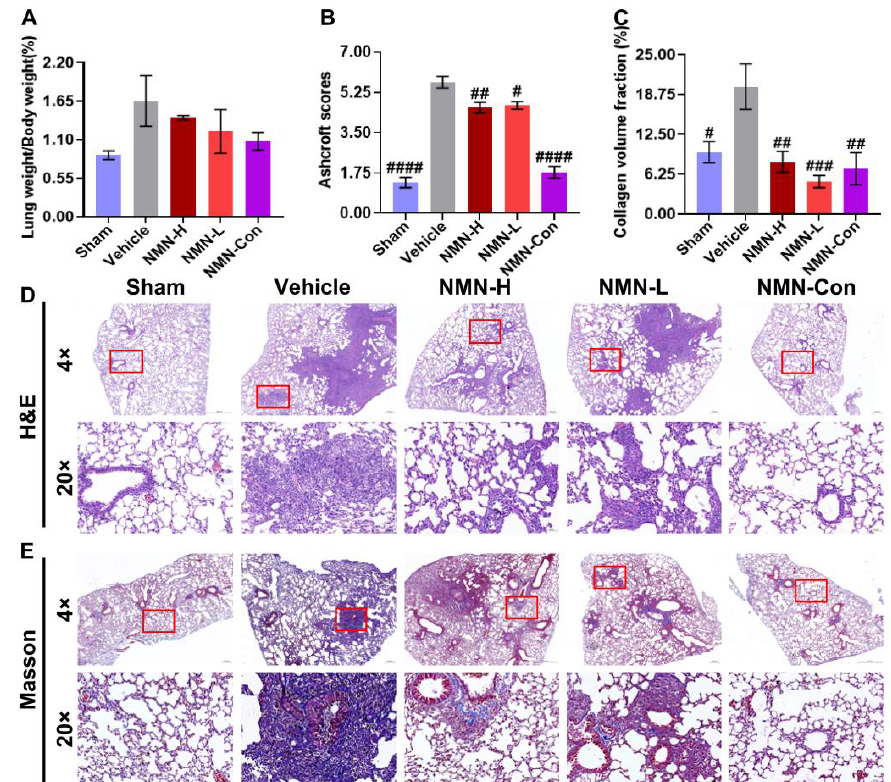
Figure 1. NMN intervention for 7 days ameliorates silica-induced lung injury in mice. ( A ) Lung weight coefficient (the ratio of lung wet weight to body weight) increased during injury induced by silica; ( B ) Ashcroft scores of lung tissue — associated with the severity of lung lesions — increased after silica induction; ( C ) collagen volume fraction of lung tissue —an indicator of collagen fibers’ expression in tissues — where silica induced deposition of collagen fibers in lung tissues; ( D ) H&E staining images of lung tissue; ( E ) Masson staining images of lung tissue. Scale: 4×, 20×, the images for 20× are derived from the red box in 4×. # indicates p < 0.05, ## p < 0.01, ### p < 0.001, #### p < 0.0001 vs. Vehicle. Sham: saline + saline; Vehicle: silica + saline; NMN-H: silica + NMN (1000 mg/kg); NMN-L: silica + NMN (500 mg/kg); NMN-Con: saline + NMN (1000 mg/kg). After 28 d of silica infusion, the lung weight coefficient of mice had significantly in- creased; the pathological scores and collagen volume fraction were significantly greater; the lung tissue structure was seriously damaged, accompanied by diffuse cell prolifera- tion; and the deposition of collagen fibers in the interstitial tissue had significantly in- creased (Figure 2A – E). Similar to the results for 7 d, NMN supplementation significantly attenuated lung injury, cell proliferation, and collagen deposition induced by silica. At 28 d, compared with the Vehicle group, the lung tissue structure of the NMN-H group was relatively complete, with only a few small inflammatory cell nodules. The degree of lung injury in the NMN-L group was also lower than that in the Vehicle group, suggesting that NMN continuously alleviates silica-induced lung injury.